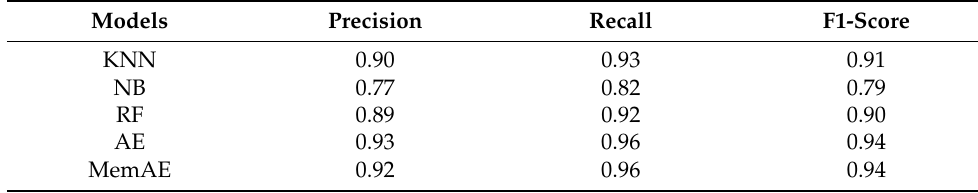
Table 7. Malicious behavior detection results by model using the original dataset. Models